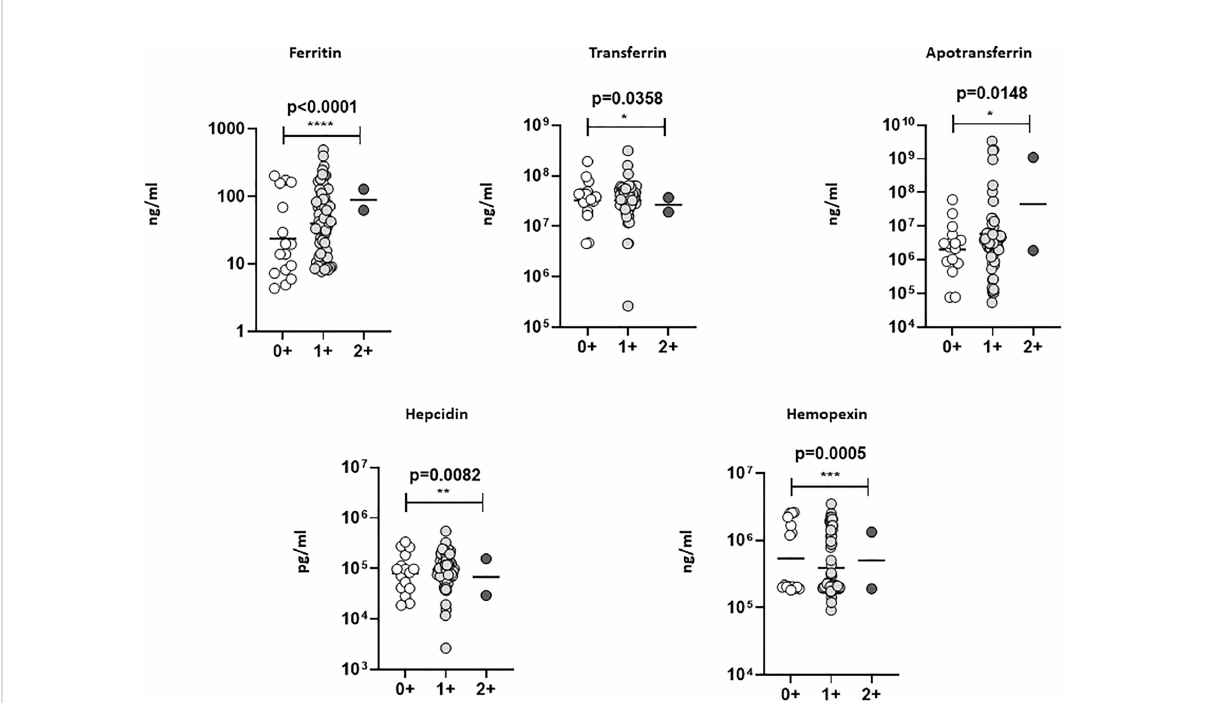
FIGURE 5 Linear (trend) regression analysis of iron status biomarkers. The association between plasma levels of iron status biomarkers was correlated with lymph node culture grades (TBL+ (Ss+, n=44 and Ss-, n=44) individuals) using linear trend analysis (one-way ANOVA). The results were shown as scatter plots with each circle denoting a single individual. The signi fi cance of p values was represented as '*' p<0.05, '**' p<0.01, '***' p<0.001, '****'